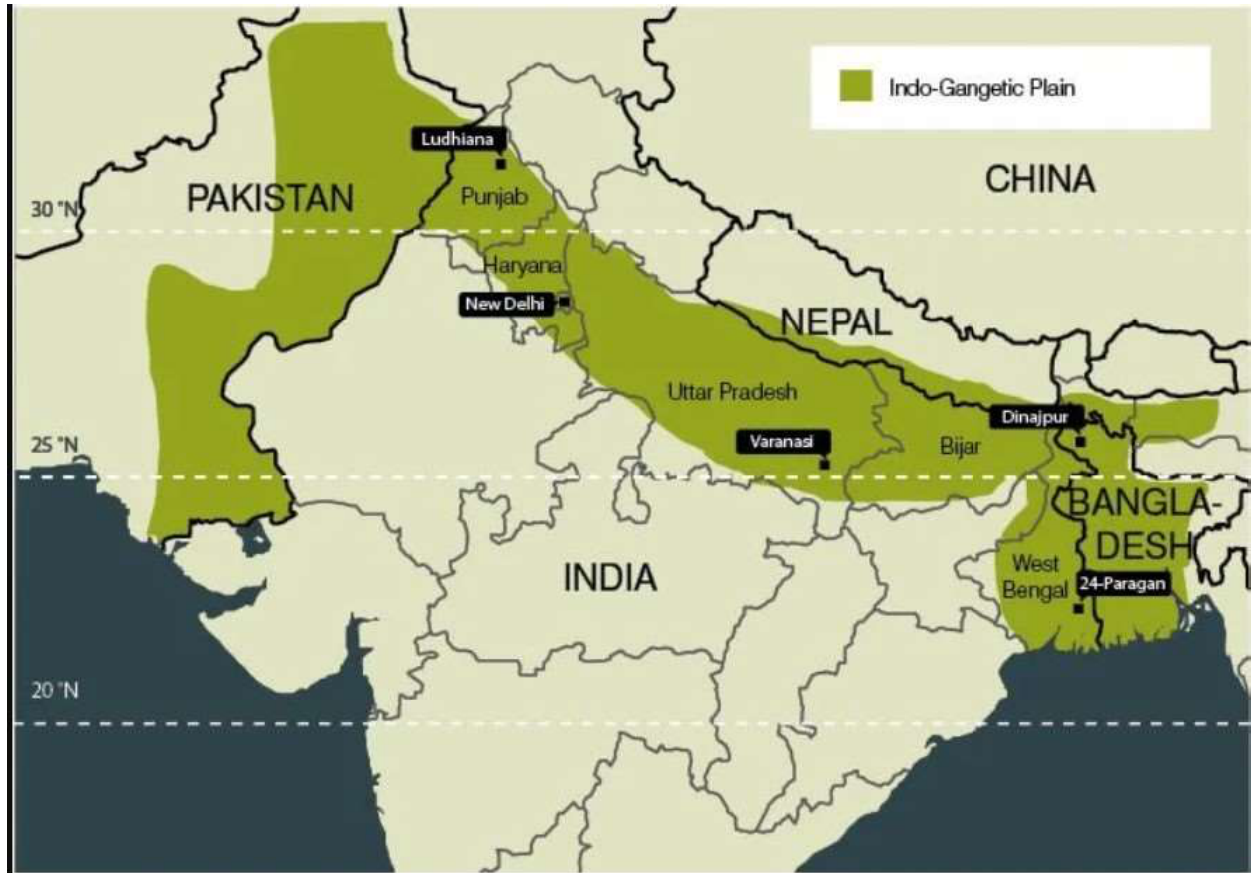
Figure 1. Indo-Gangetic plains (Source www.pinterest.com.au, accessed on 10 March 2023) (1 and 2, trans-Gangetic plains; 3, upper Gangetic plain; 4, middle Gangetic plain; and 5, lower Gangetic plain). Table 1. Physiographic information of Indo-Gangetic plains.